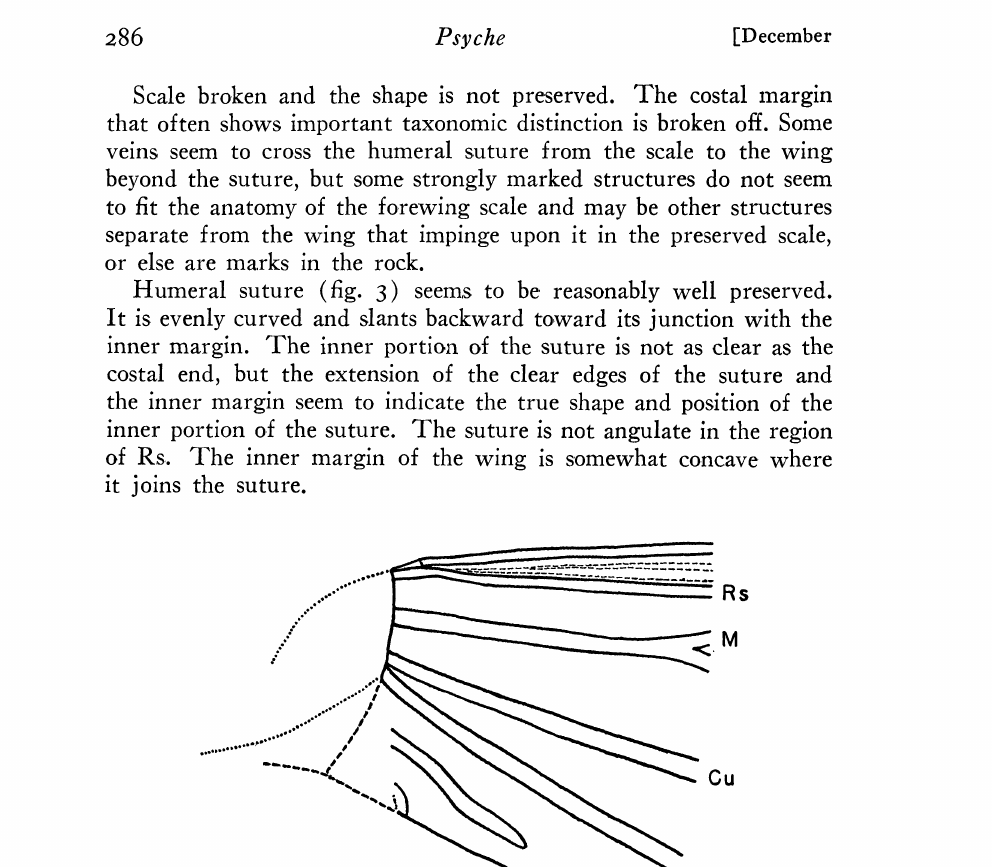
Fig. 3. Drawing of base. of holotype forewing of Gretatermes carpenteri, new genus, new species, showing visible veins emerging t?rom the humeral